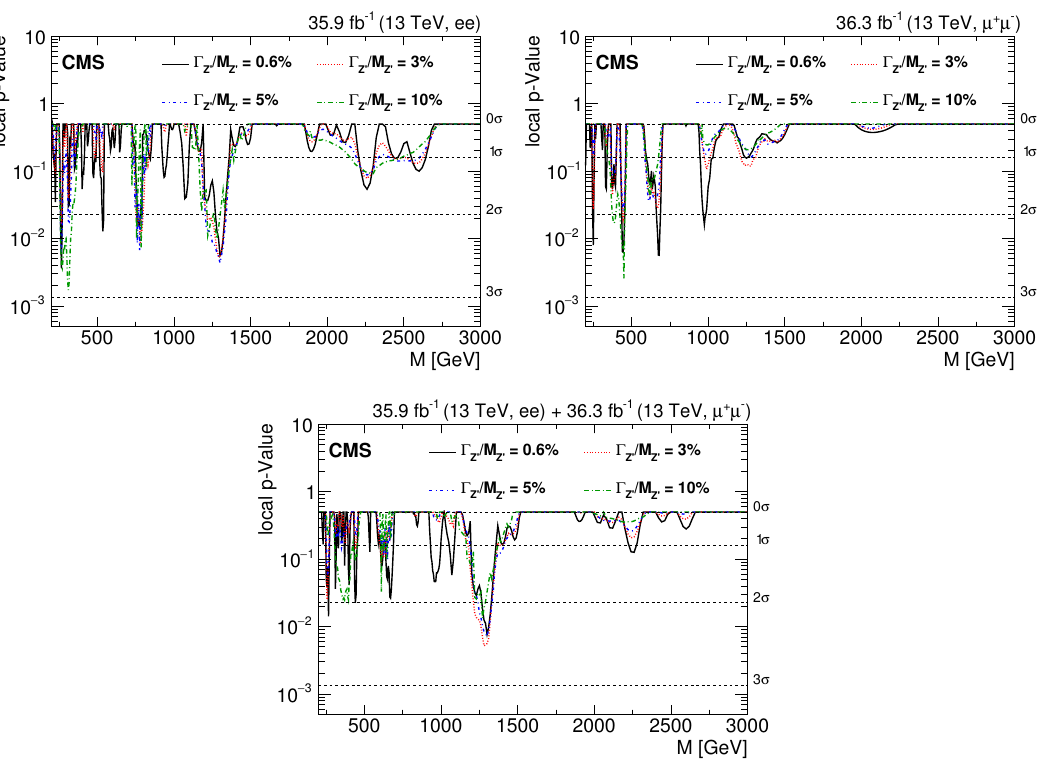
Figure 6 . The observed local p -value for the dielectron channel (left), dimuon channel (right), and their combination (lower) as a function of the dilepton invariant